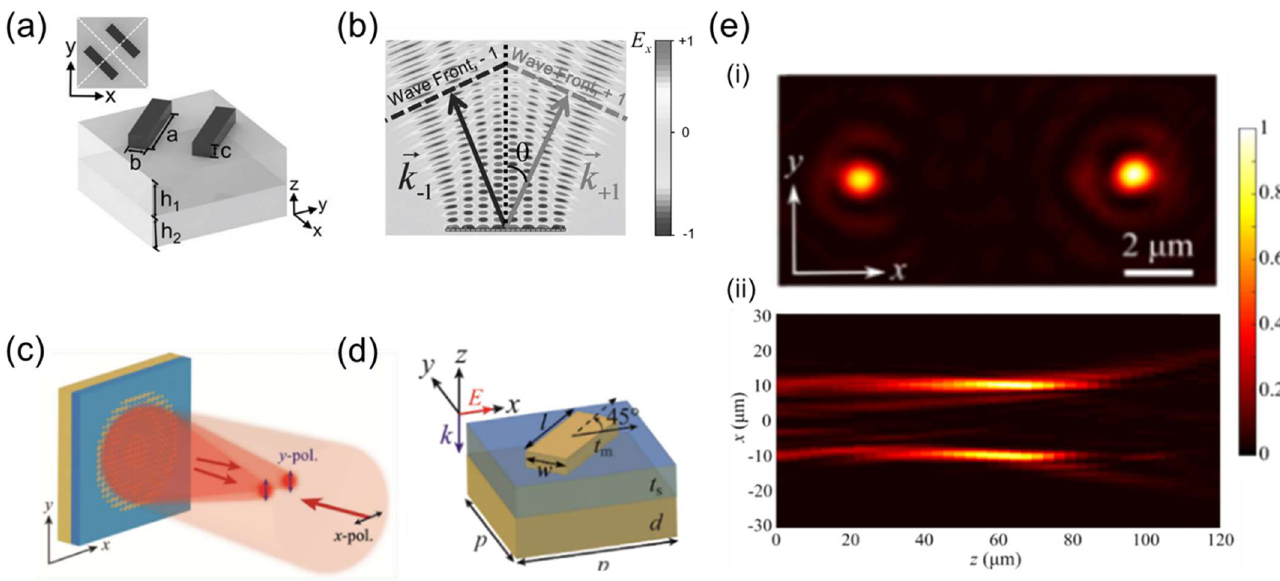
Figure 8. ( a ) Schematic diagram of the silver DBS metasurface. Reprinted from [97], with the permission of AIP Publishing. ( b ) The x−component of the y −polarized normal incident beam at 1400 nm simulates the electric field distribution. Reprinted from [97], with the permission of AIP Publishing. ( c ) Schematic diagram of the working of a bifocal metalens that reflects a normally incident 𝑥 polarized beam and splits it into two 𝑦 polarized focusing points [99]. ( d ) Schematic magnification of the unit cell of the bifocal element lens [99]. ( e ) ( i ) Measured focal spot profiles in cross−polarization. ( ii ) Measured intensity profiles of the reflected beam in the 𝑥 − 𝑧 plane in cross-polarization [99].